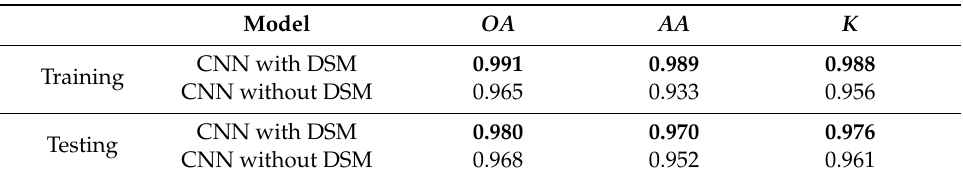
Figure 6. Training and validation loss of information when fusing DSM and RGB ( left ), and loss of information with RGB only ( right ). Table 2. Performance of the classification methods used in the current study measured using standard accuracy metrics.